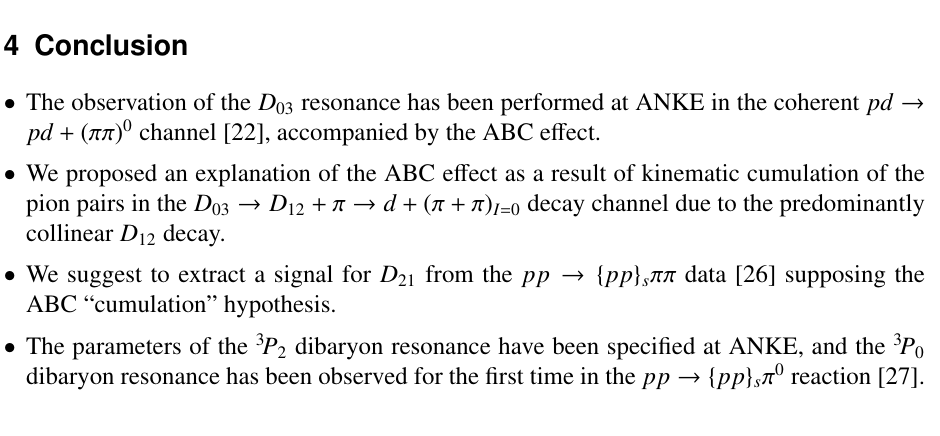
Figure 3. Event counts with respect to the invariant mass of the d η system m dX for the pd → pd + X reaction in the missing mass region 295 MeV ≤ m 2 X < 310 MeV. The curve is a fit by the Breit-Wigner function plus constant background (cid:3)(cid:4)(cid:5) (cid:6) (cid:2) Γ 2 / 4 ( m dX − m 0 ) 2 + Γ 2 / 4 . Its bg + N parameters are N = 82 ± 8, = 2432 ± 2 MeV / c 2 , Γ = 20 ± 3 MeV / c 2 , and m 0 bg = 4 ±